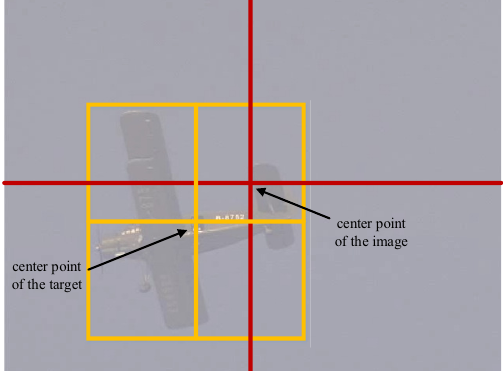
Figure 4. The difference between the center of the current frame and that of the